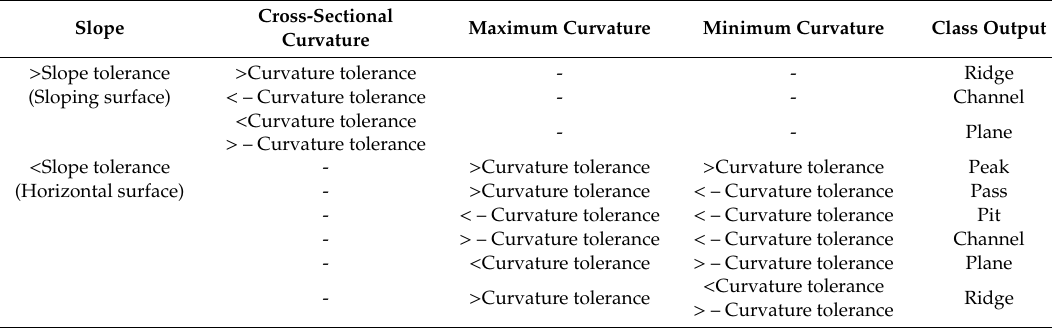
Table 1. Wood’s criteria for the classification of geomorphic